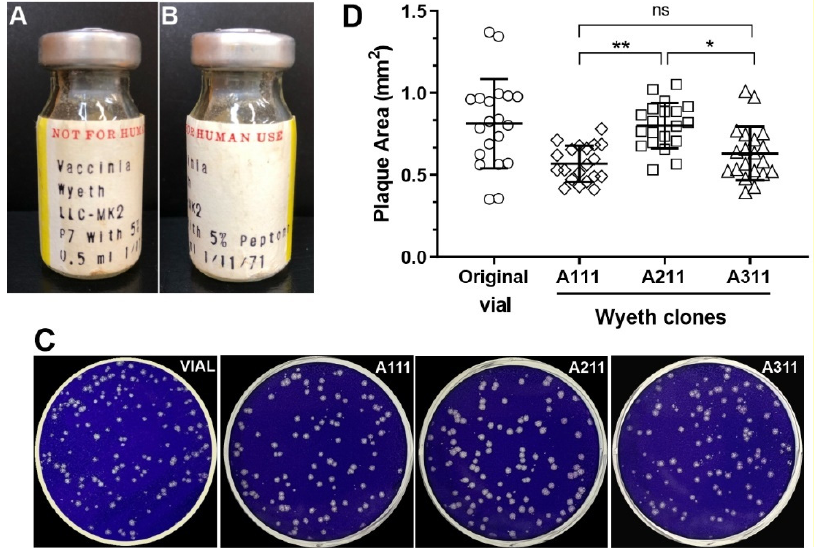
Figure 1. Clone isolation of VACV-Wyeth and plaque phenotype. ( A , B ) Original vial of lyophilized VACV-Wyeth propagated in LLC-MK2 in 1971. ( C ) Representative images of crystal-violet stained BSC-40 cells infected with 10 -6 dilution of the original vial before plaque selection and stocks of Wyeth clones A111, A211, and A311. ( D ) Random viral plaques ( n = 20) were photographed at 4x magnification, and the individual areas were measured. Circles: plaques of the original vaccine vial; diamonds: plaques of clone A111; squares: plaques of clone A211; triangles: plaques of clone A311. Asterisks: * p ≤ 0.05 and ** p ≤ 0.01; ns means non-significant.